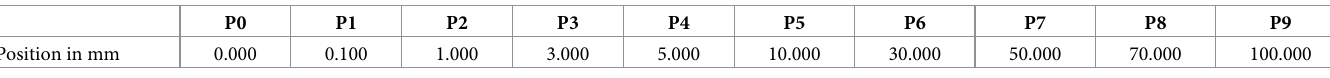
Table 2. Positions for the translational accuracy measurement using the